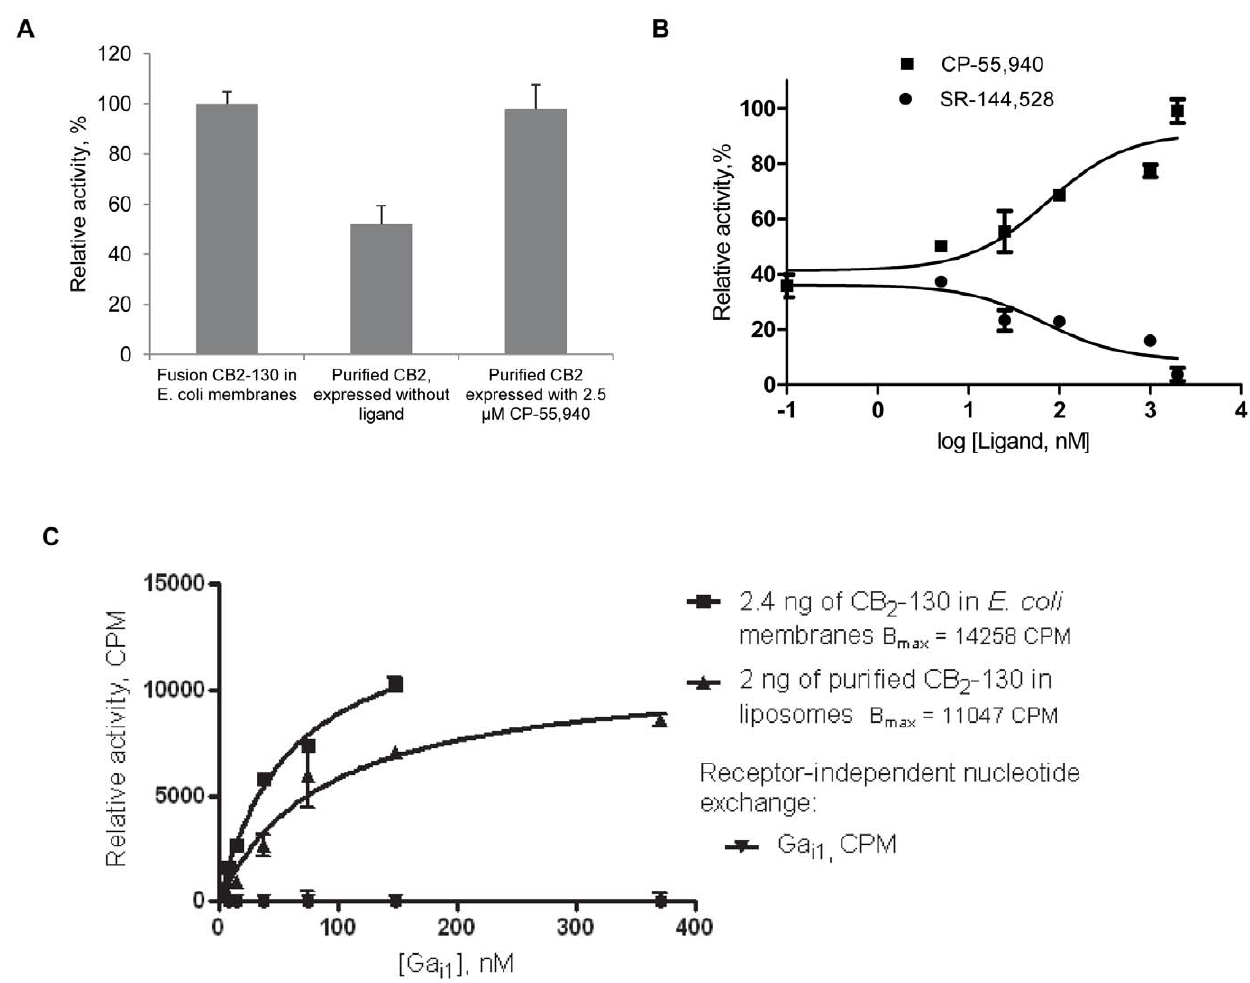
Figure 8. Functional activity of CB 2 in liposomes. A, Effect of 2.5 m M CP-55,940 in growth media of E. coli BL21 (DE3) expressing CB 2 -130 on functional activity of purified and liposome-reconstituted CB 2 . Purified protein was reconstituted into liposomes containing POPC:POPS:CHS (60:15:25 w/w/w) at a protein-to-lipid ratio 1:500, and activity measured in the presence of 2 m M CP-55,940 by the G protein activation assay. Membranes of E. coli BL21 (DE3) expressing CB 2 -130 fusion protein served as a positive control. Data represents duplicate measurements 6 S.D. (error bars) of a representative set of samples (n=3). 6 ng of the receptor was introduced into the reaction and normalization was performed assuming concentration of